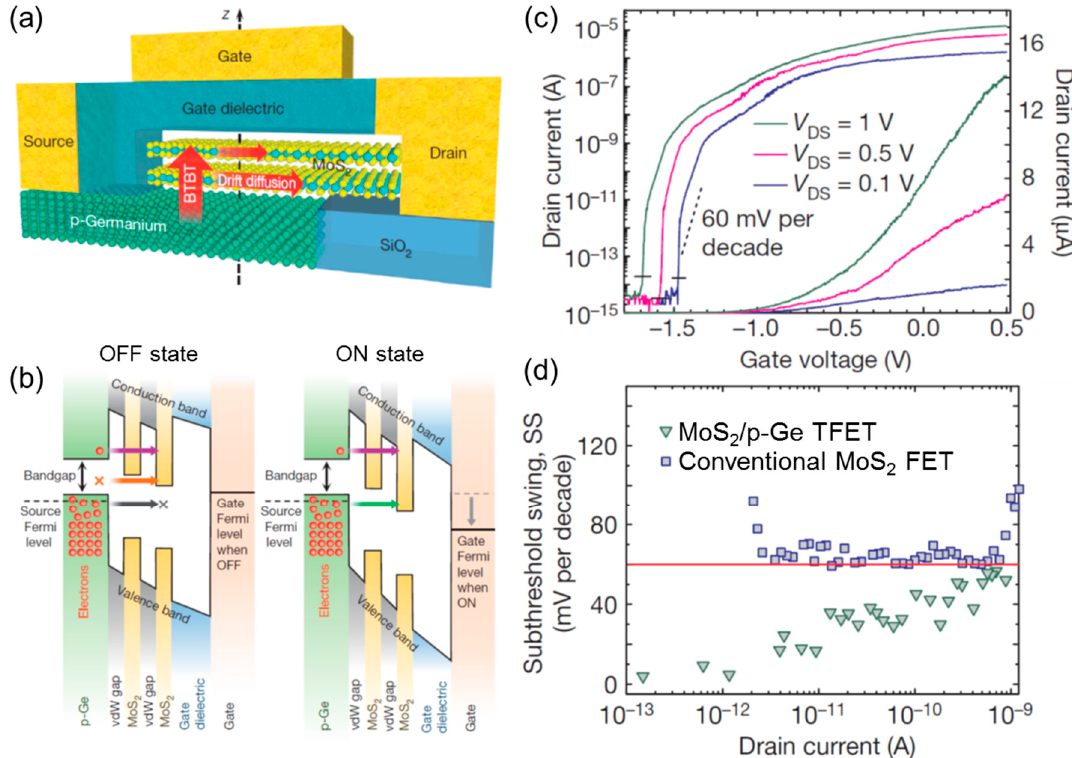
Figure 5. ( a ) Schematic cross-section of a gate-modulated bilayer MoS 2 / p -Ge junction; ( b ) band diagrams of the device in the OFF and ON state; ( c ) transfer characteristics of the device for different V DS ; ( d ) comparison of the subthreshold swing (SS) of this bilayer MoS 2 / p -Ge tunneling field effect transistor (TFET) with that of a conventional FET with a bilayer MoS 2 channel. Figures adapted with permission from [20].